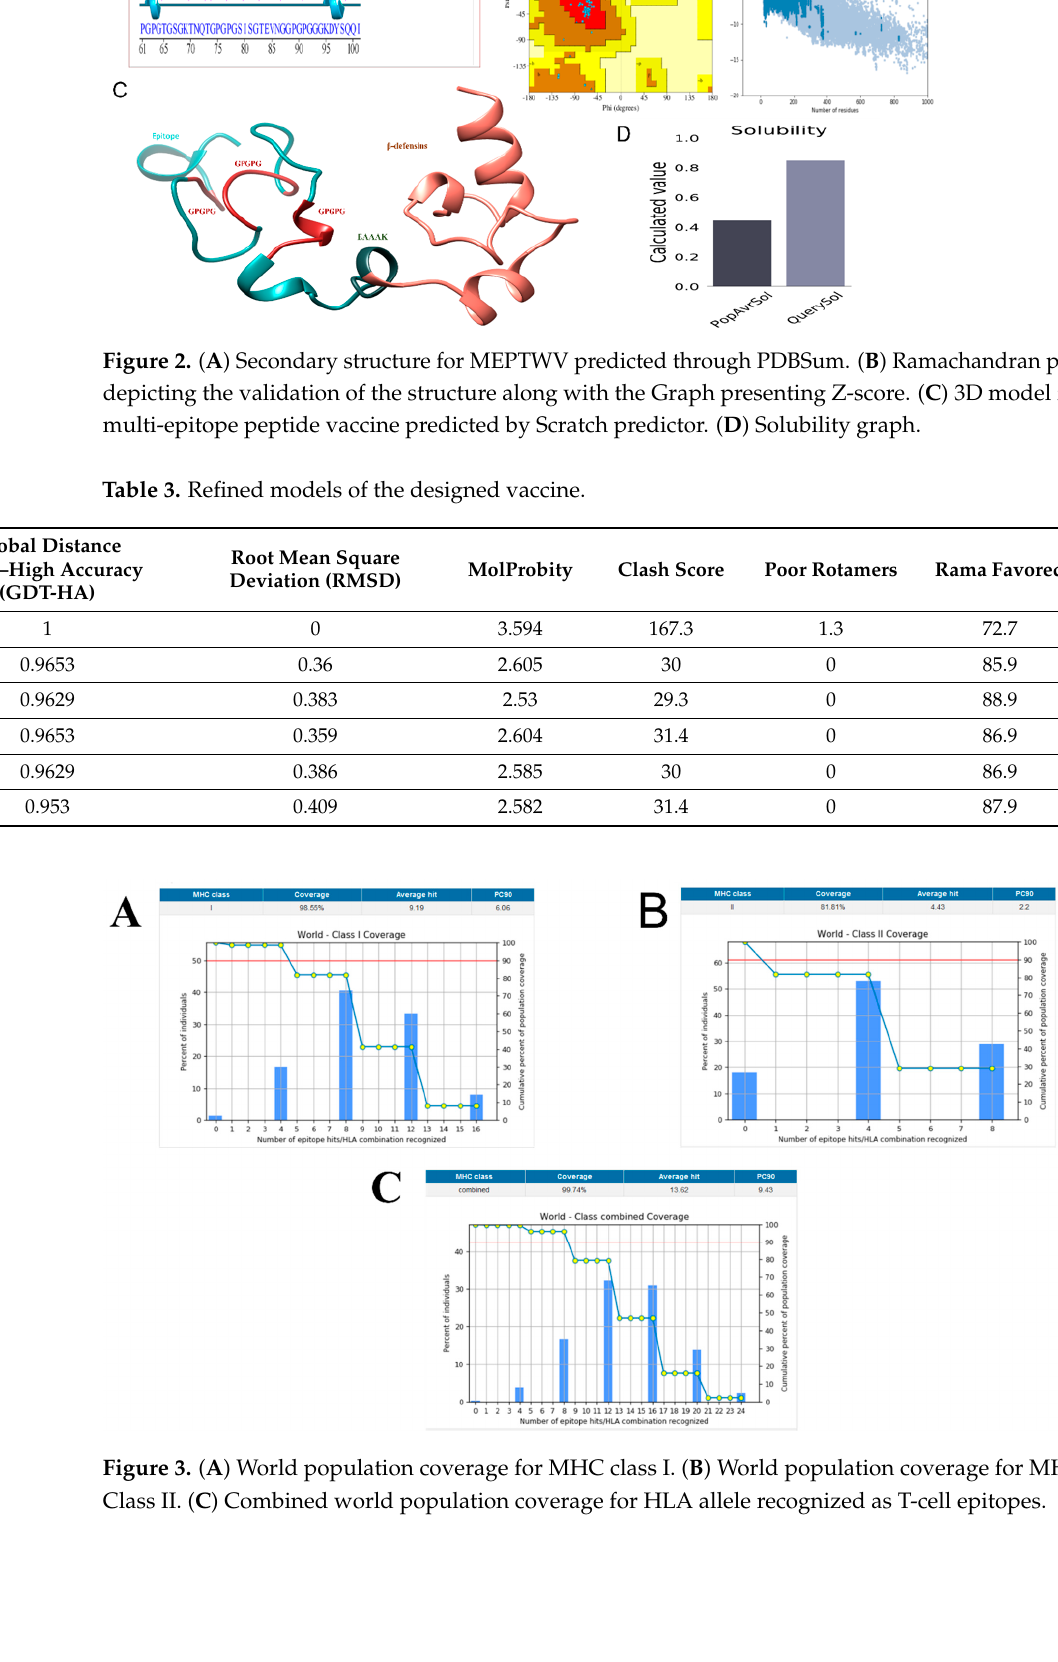
Figure 4. Region-wise world population coverage by vaccine epitopes. 3.6. Disulfide Engineering and In Silico Cloning Disulfide engineering was performed for structural stability. It involved the introduction of disulfide bonds as cysteine pairs [66]. Nine residue pairs were spotted to have a high energy value and confer instability to the vaccine conformation. The residue pairs chosen to be mutated as a cysteine residue were 11CYS-16GLY( X 3 angle, +72.29, energy value, 2.45 Kcal/Mol), 17ARG-21CYS( X 3 angle, − 75.15, energy value, 5.11